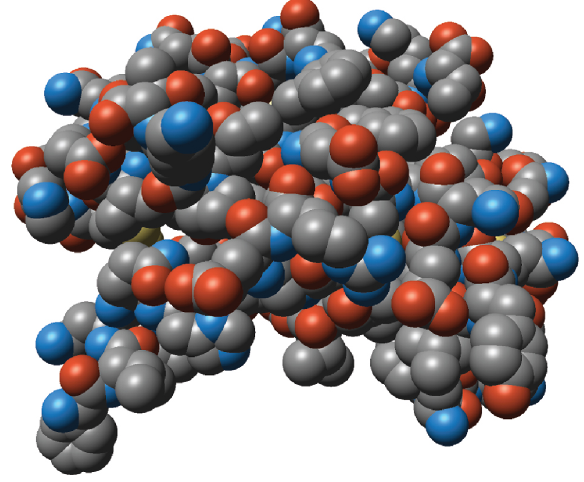
Figure 1: Rendering of the space-filling model for a small protein (PDB ID: 1RWE) coloured by element. In traditional computer graphics, objects like spheres have to be tessellated as triangle meshes prior to ren- dering. Today, GPU-based raycasting [5], [6] is the fastest way to render large numbers of implicitly defined objects of low polynomial degree (e.g. quadrics) [7]. Here, a small proxy geometry covering the whole object